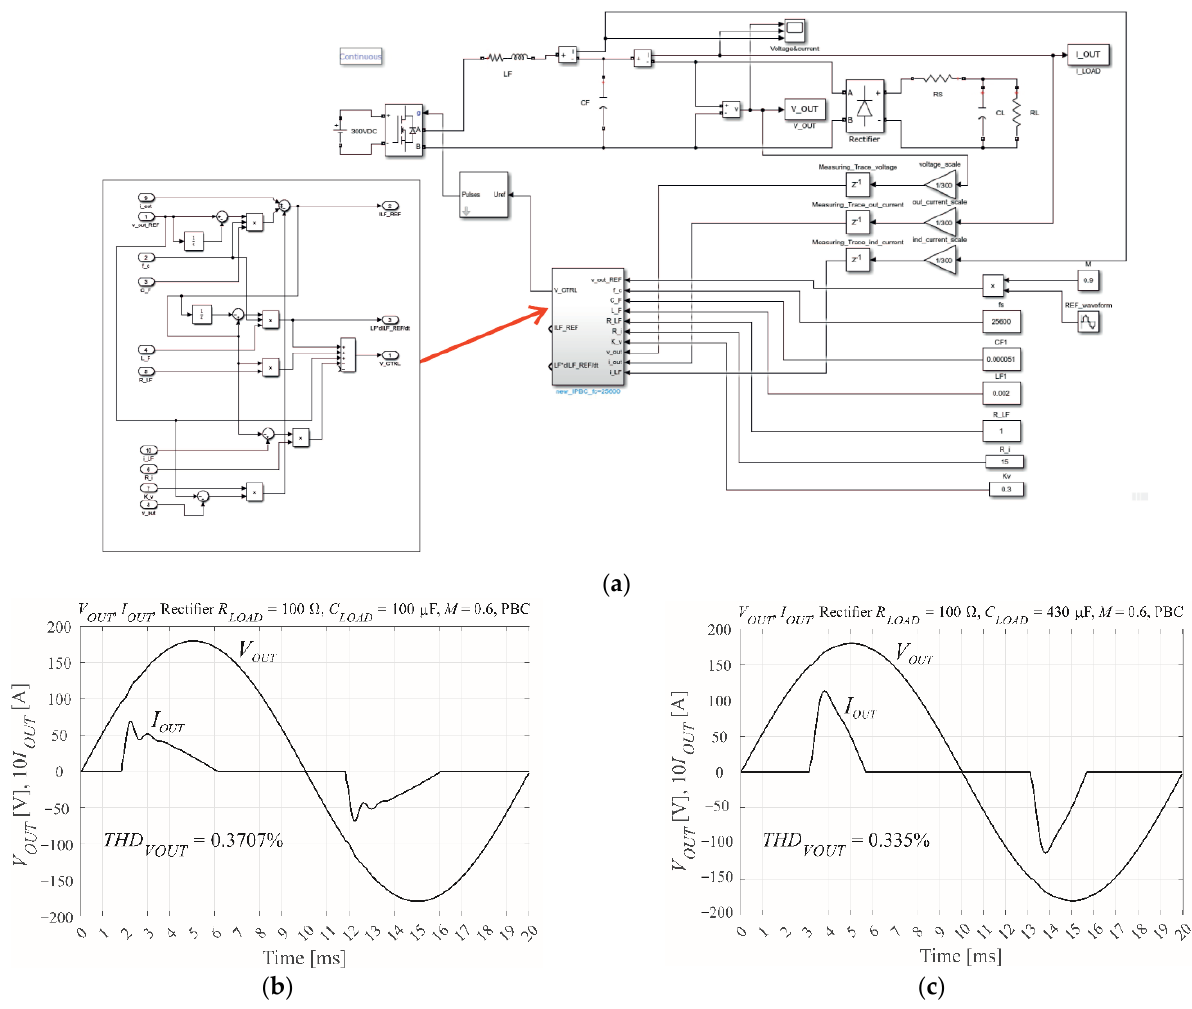
Figure 11. Overview of PBC control, showing ( a ) the MATLAB’s Simulink simulation model of the IPBC2 controller and the simulation model of the inverter with the nonlinear rectifier RC load, ( b ) the simulated output voltage and current with R = 100 Ω, C = 100 μF, and M = 0.6, and ( c ) the simulated output voltage and current with R = 100 Ω, C = 430 μF, and M = 0.6.